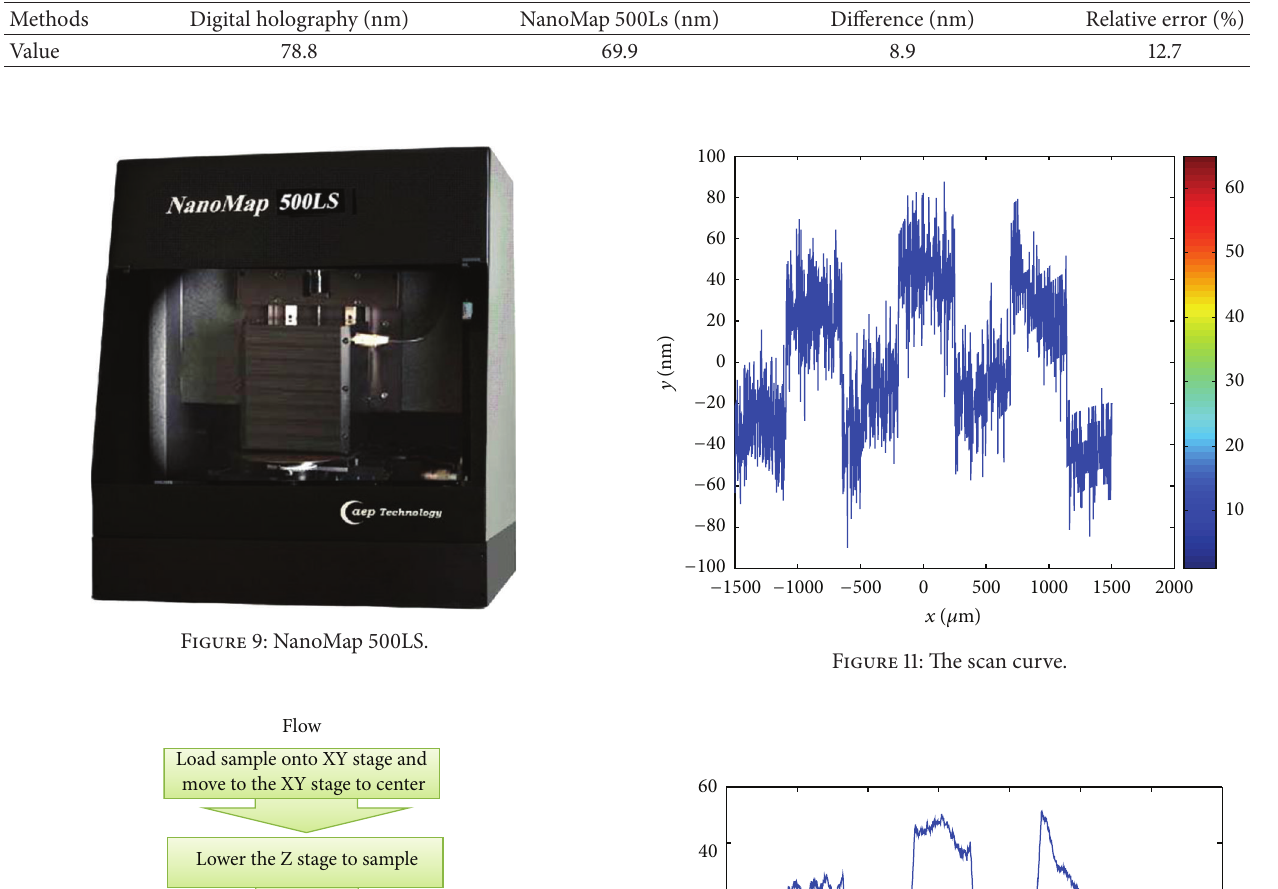
Table 3: Comparison of the measurement results by two methods.